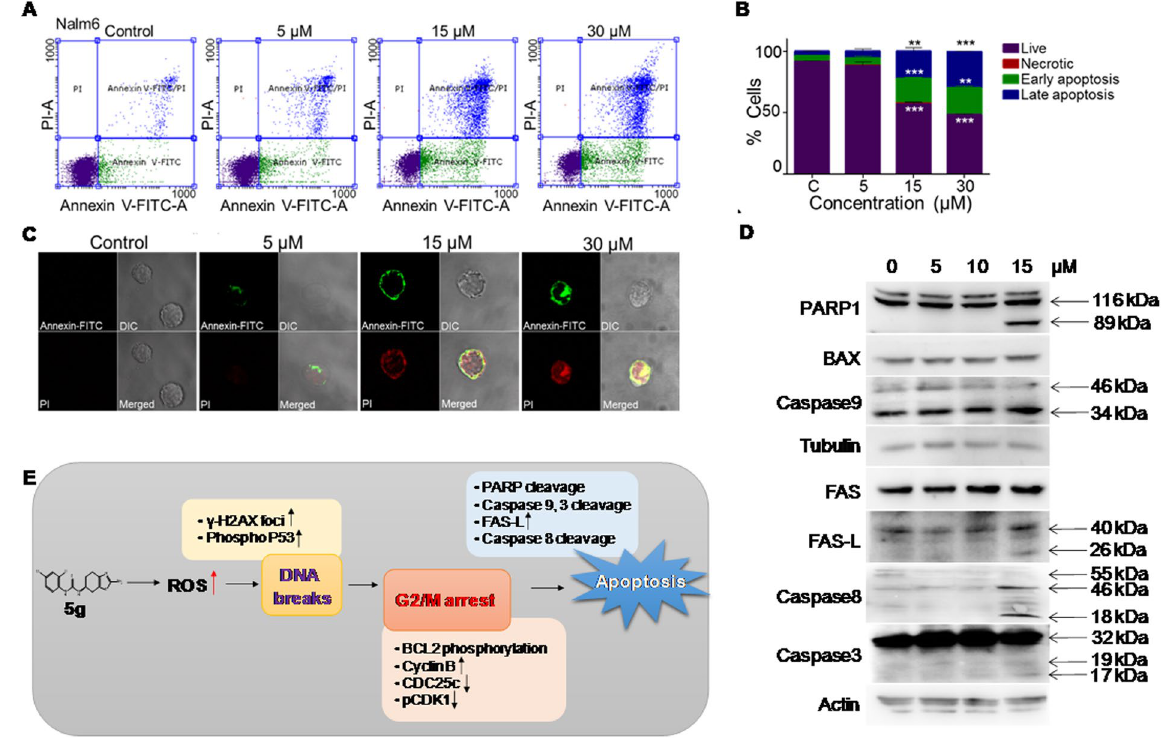
Figure 7. Analysis of mechanism of induction of apoptosis following treatment with 5g in Nalm6 cells. ( A ) Dot plots showing annexin-FITC/PI staining of 5g-treated (0, 5, 15 and 30 µ M; 48 h) Nalm6 cells. Following staining, samples were analysed on FACS and images were captured using confocal microscope. 5g-treated Nalm6 cells at different concentration. ( B ) Cells which are positive for annexin-FITC, PI and both annexin-FITC/PI were quantified and represented in bar diagram. ( C ) Confocal microscopy images of 5g-treated cells with 100x magnification. Statistical significance was calculated using student t-test and significance was shown if the p-value was equal to or less than 0.05 ( * 0.05, ** 0.005, *** 0.0005). ( D ) Western blotting analysis for apoptotic markers following 5g treatment in Nalm6 cells. Apoptotic related proteins were analysed in 5g-treated (0, 5, 10 and 15 µ M; 48 h) Nalm6 cells. PARP1, BAX, Caspase9, FAS, FAS-L, Caspase8, Caspase3 specific antibodies were used; Actin served as loading control. ( E ) Model describing the mechanism of action of 5g inside cells. 5g treatment leads to a potent G2/M phase arrest, caused by increased ROS levels and subsequent DNA damage. 5g treated cells eventually undergo cell death by activation of the intrinsic and extrinsic pathway of